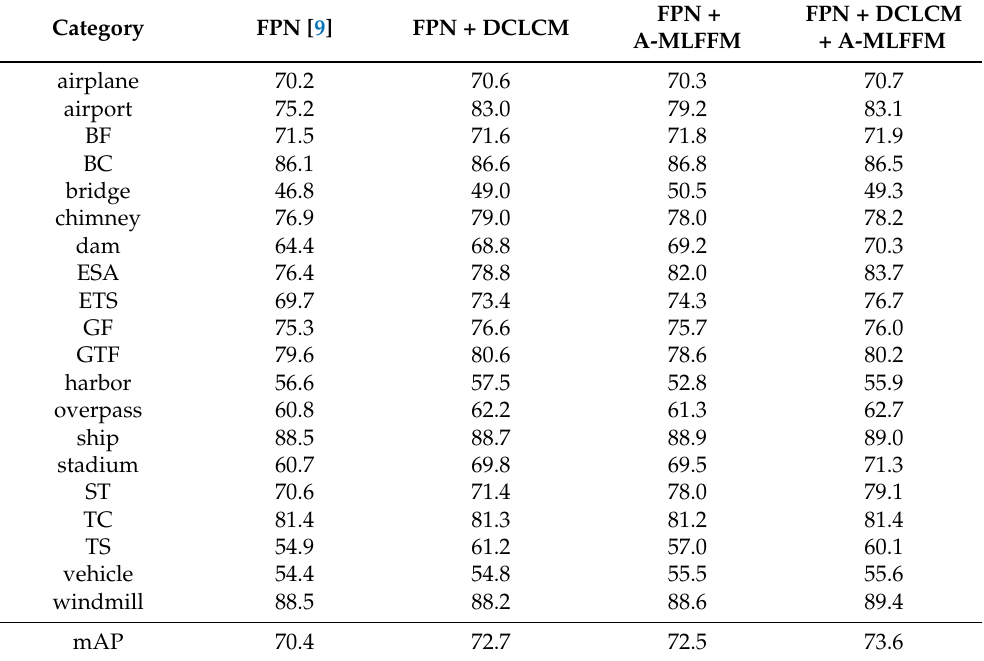
Table 1. Detection accuracy comparisons between FPN and FPN with different combinations of DCLCM and A-MLFFM on the DIOR